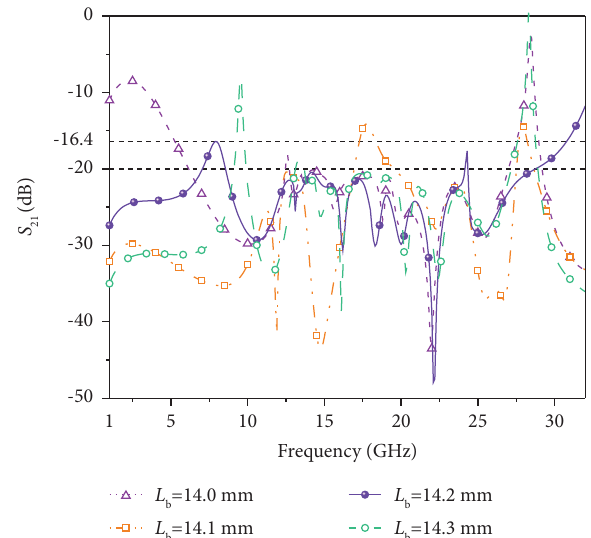
Figure 8: S 21 results for diferent values of L b